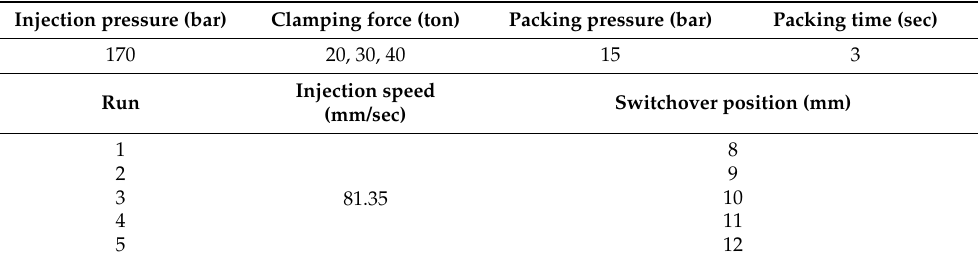
Table 6. Experimental parameters for three seconds of packing time with different amounts of clamping